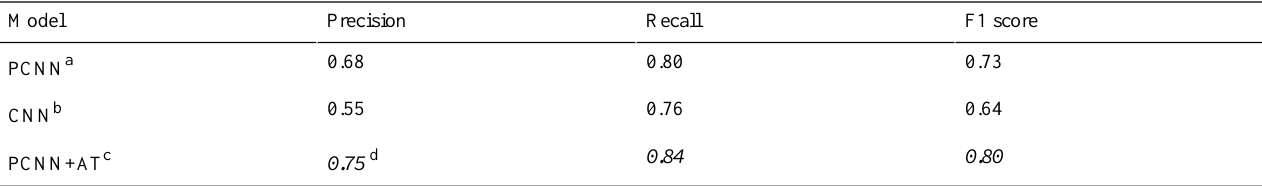
Table 8. Results of each model for overall relation